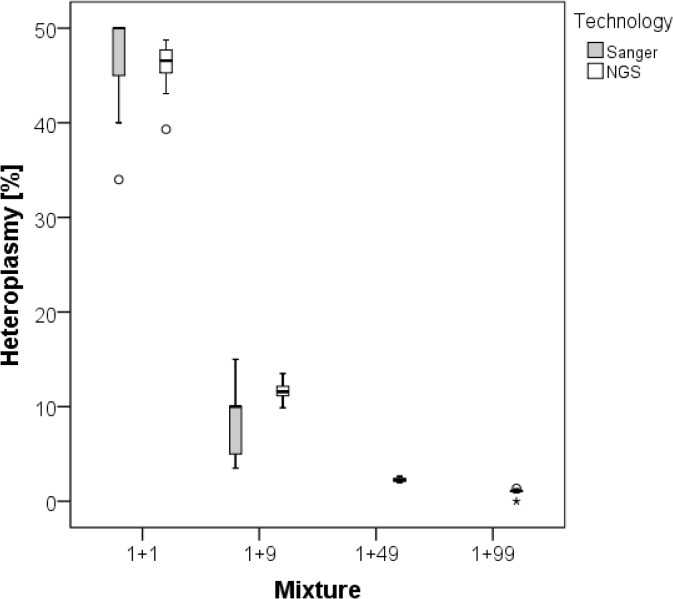
Percentage of the minor component on heteroplasmic positions as obtained with Sanger sequencing and next-generation sequencing on an Illumina HiSeq platform.The samples contained pre-defined mixtures of the DNA of two lab members. In Sanger electropherograms, heteroplasmies were neither detected in the 1+49 mixture nor in the 1+99 mixture.